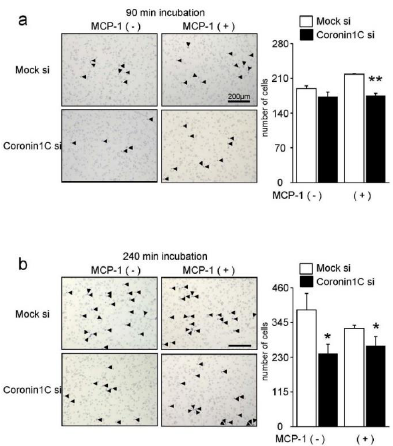
Figure 7. Chemotaxis of the Mock and Coronin1C-knockdown RAW-D cells. Chemotaxis was evaluated using a Transwell chamber. The cells in the 24-well chambers were treated with or without MCP-1 (0.1 nM) at 37 ◦ C for 90 min ( a ) or 240 min ( b ). The cells that migrated from the upper to the lower well were fixed and stained with hematoxylin solution. The number of cells was counted by light microscopy. The arrowheads indicate cells. * p <0.05, ** p < 0.01; compared with the mock si.